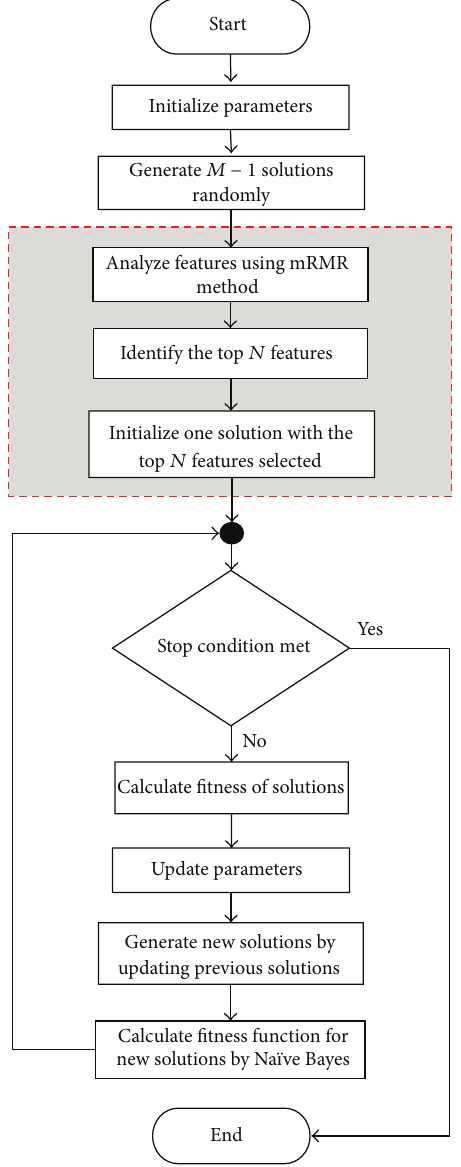
Figure 1: Flowchart of Bat Algorithm with Mutual Information.